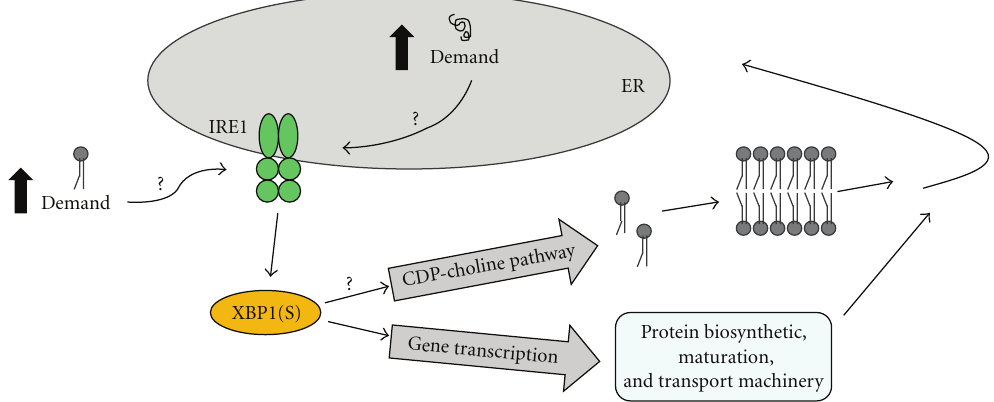
Figure 2: XBP1(S), lipids, and secretory pathway machinery in ER biogenesis. In activated B cells, we propose that increased demand for lipids as well as increased demand on the protein folding capacity of the ER promotes induction of the XBP1(S) transcriptional activator via the IRE1/XBP1 branch of the UPR. The means by which these demands are sensed by the IRE1/XBP1 pathway remain unclear. XBP1(S), via transcriptional control, upregulates expression of a large cohort of proteins involved in the synthesis, maturation, and transport of cargo proteins within the secretory pathway. Much of this secretory machinery localizes to the ER. XBP1(S), via mechanisms that are poorly understood, also drives lipid biosynthesis, including production of the major phospholipid PtdCho by the CDP-choline pathway. Thus, XBP1(S) coordinates mechanisms that supply both the lipid and protein components necessary for construction of the ER.